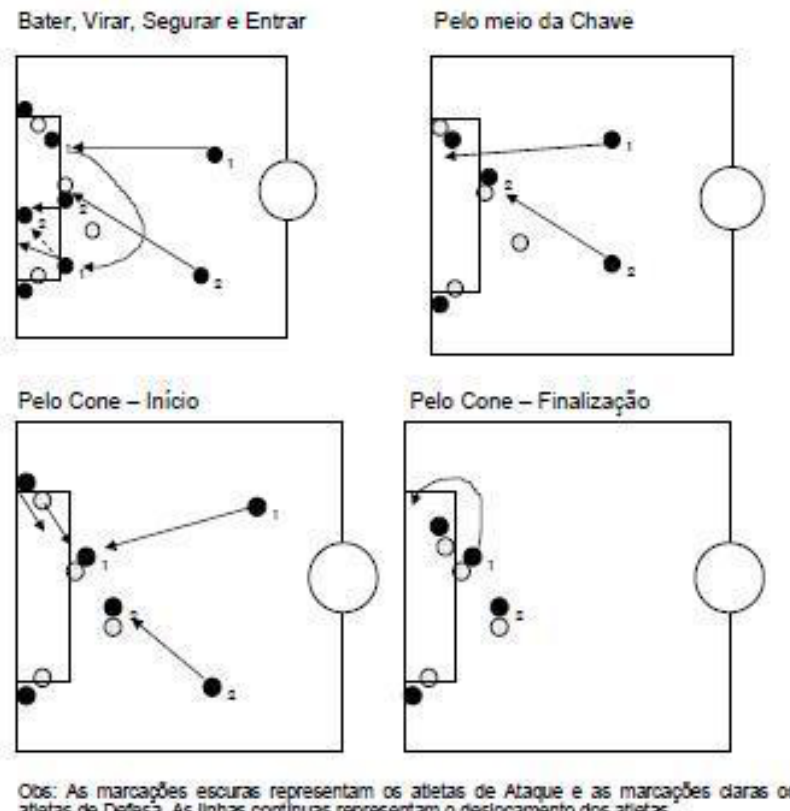
Figura 6. As Principais Jogadas de